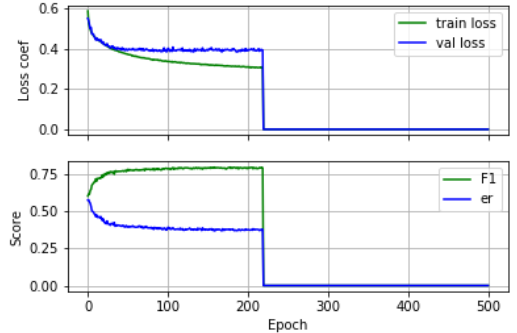
Figure 10. Learning curves for the best set of parameters.